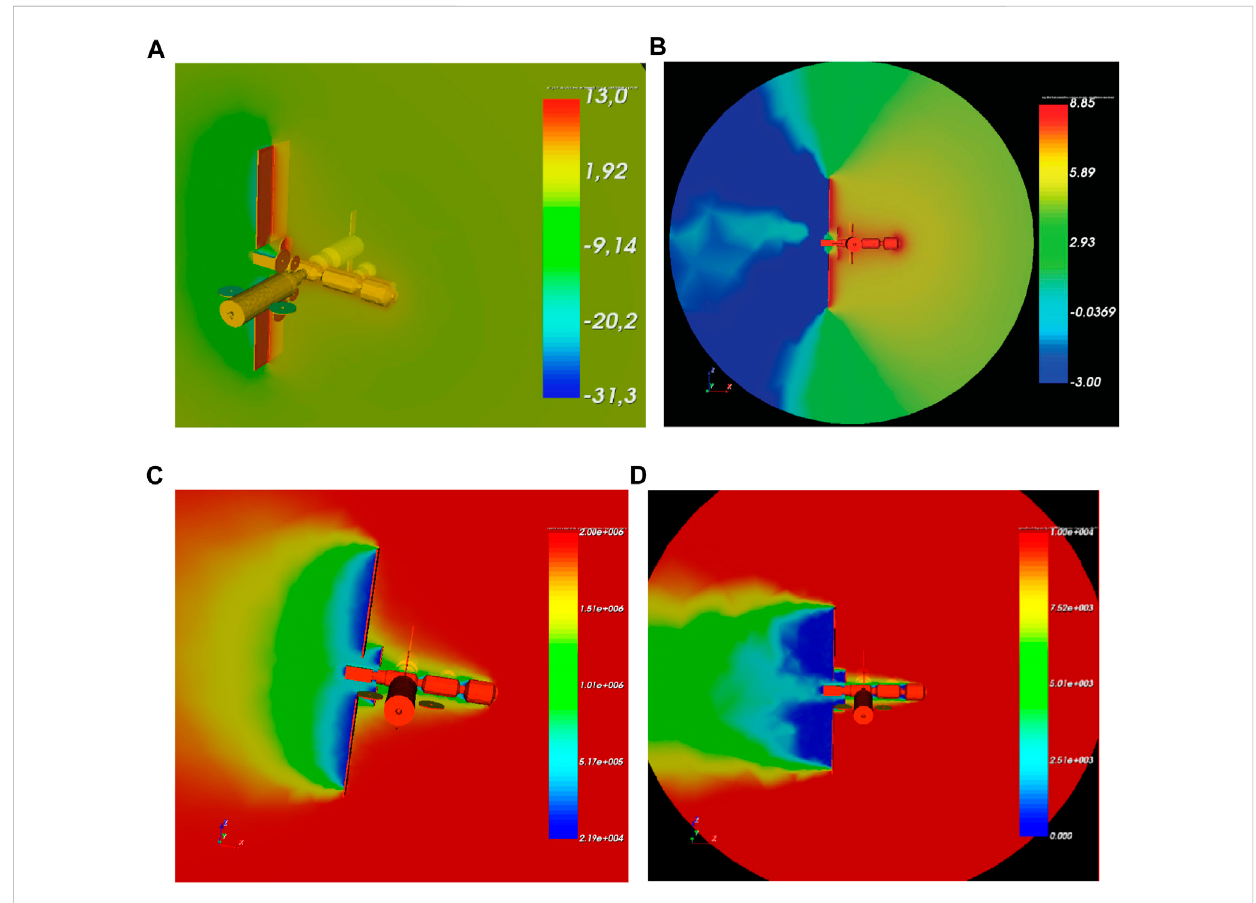
FIGURE 14 SPIS simulation of the volume electrostatic potential distribution (in V) in the terrestrial magnetotail (A) , with the Gateway aligned to the solar direction,andphotoelectrondensity(logscale)underthesameconditions (B) .H + iondensity (C) andO + iondensity (D) intheterrestrialmagnetotail,both in m -3 , showing the plasma wake downstream of the